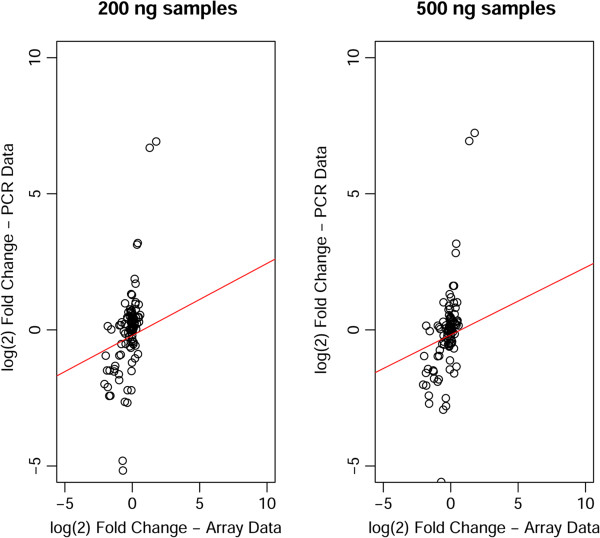
Correlation between the microarray and the Fluidigm GEx PCR array data. The figure summarizes the correlation between the logarithmic microarray data and the validation results for both the 200 ng and 500 ng samples. For validation purposes we used the polymerase chain reaction-based (PCR-based) Fluidigm GEx array with 19 genes and upon receiving the results, the numerical analysis was performed with the inbuilt corr.test function of the R statistical computing program. The results are in agreement with the commonly observed decreasing accuracy of the fold change values of the microarray method at the higher and lower ends. The correlation coefficients were 0.619 and 0.610 for the 200 ng and 500 ng samples, respectively. Red line represents the regression line.